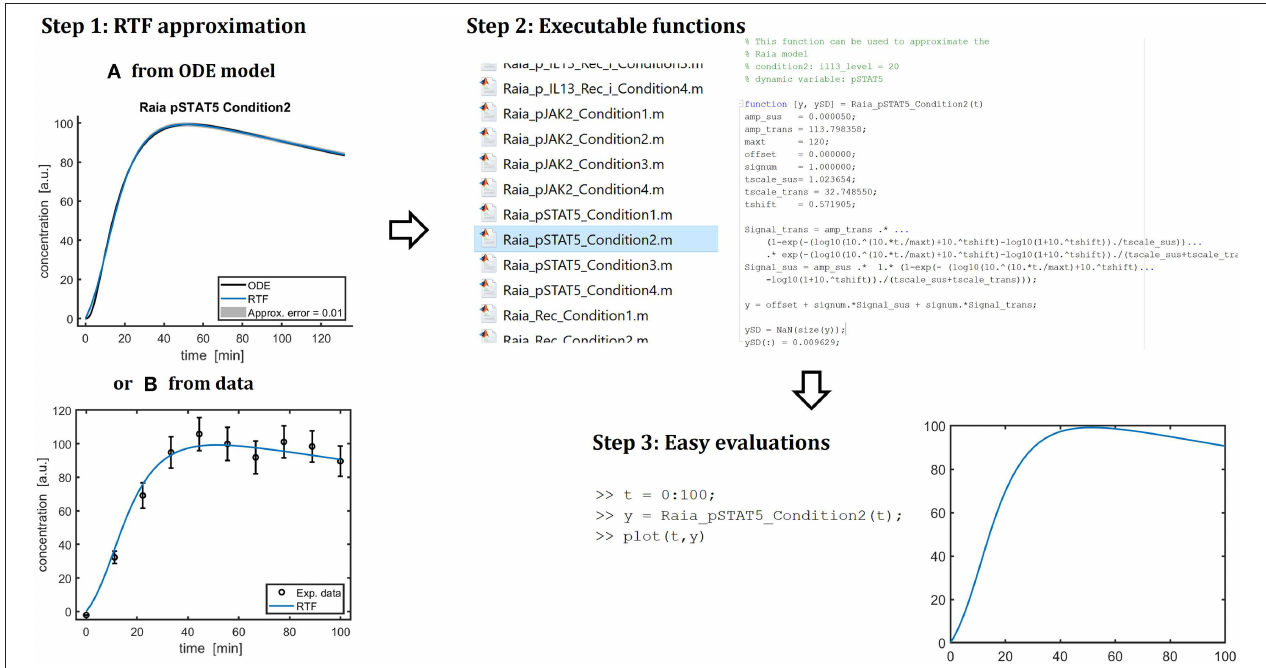
FIGURE 5 | Summary of the presented approach. As a first step, the retarded transient function (RTF) can be applied to approximate ODE solutions (A) or can be fitted to data directly (B) . My implementation can generate Matlab code with the fitted parameters (“Step 2”). Then, these function can be called conveniently to evaluate the dynamics of a specific compound in a specific experimental condition (“Step 3”). Moreover, the explicit form of a fitted RTF enables an easy transfer to other applications and modeling